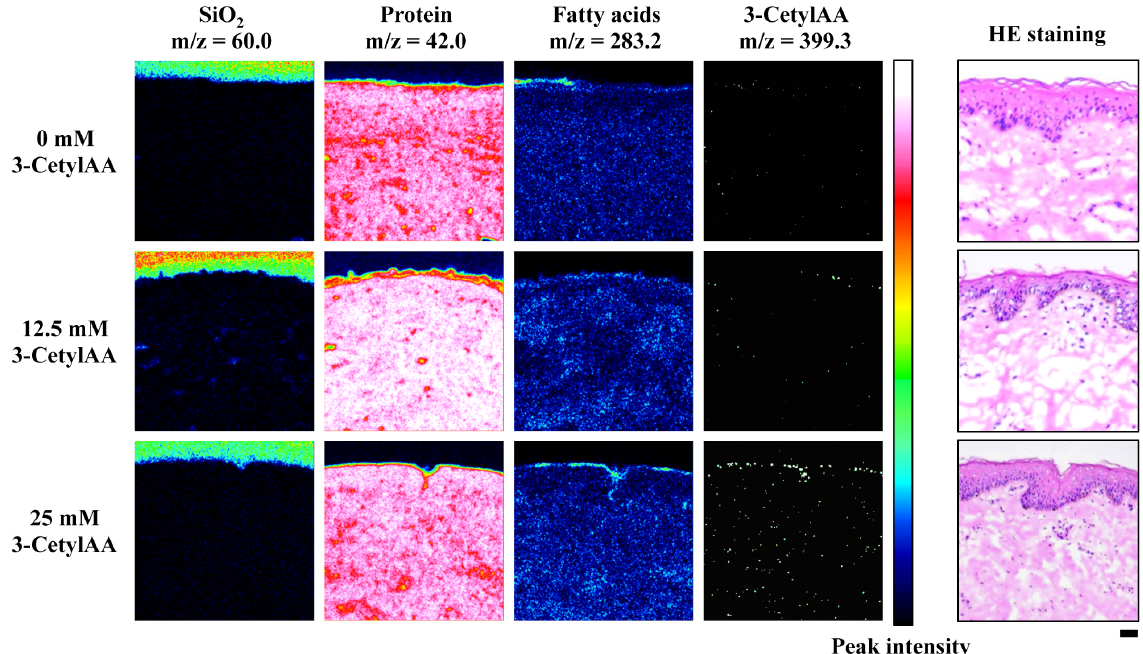
Figure 2. ToF-SIMS images (left to right: SiO 2 , protein, fatty acids, and 3-CetylAA) and optical micrograph (HE staining), with the same analysis area (500 µm × 500 µm). Scale bar, 50 µm.